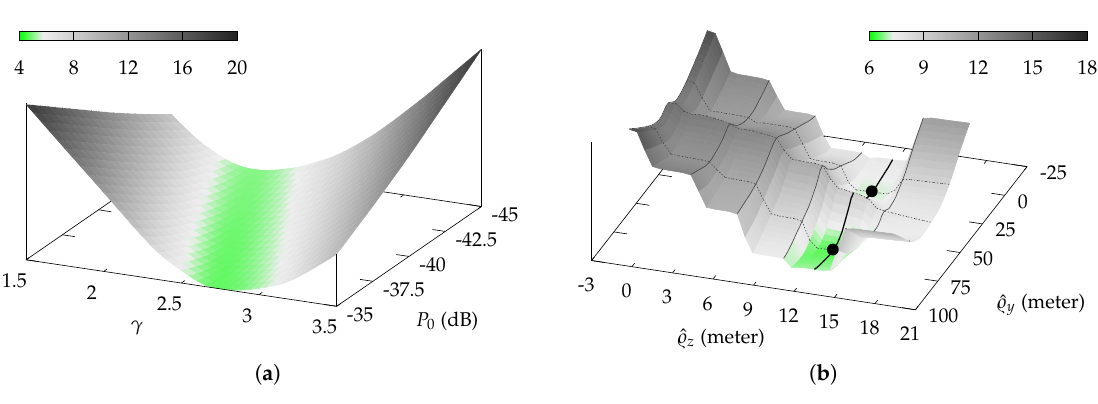
Figure 1. Average error (in dB) between all reference measurements and corresponding model predictions for one AP. ( a ) Modifying TX-power P 0 and path loss exponent γ (known position ˆ (cid:36) , fixed β ) denotes a convex function; ( b ) modifying the y - and z -position (fixed x , P 0 , γ and β ) denotes a non-convex function with multiple local